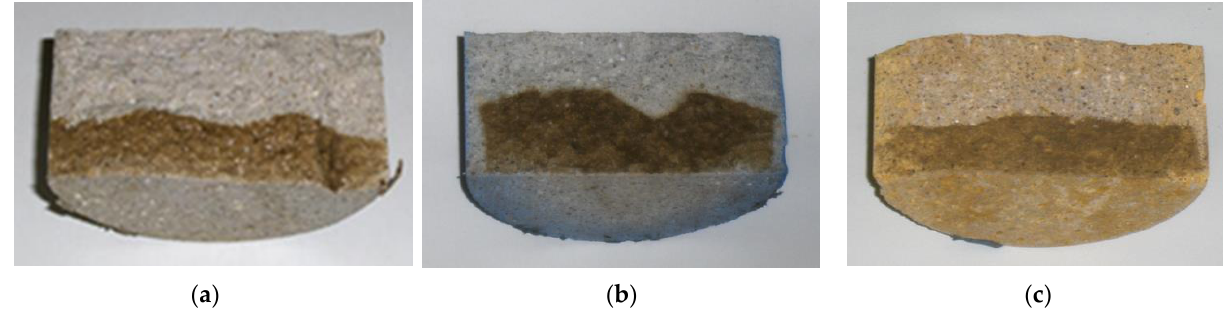
Figure 4. Average value of the depth of penetration xd according to AgNO 3 sprinkling on samples: ( a ) WRM 56 days; ( b ) BLU4% 28 days; ( c ) YEL2.5% 56 days.